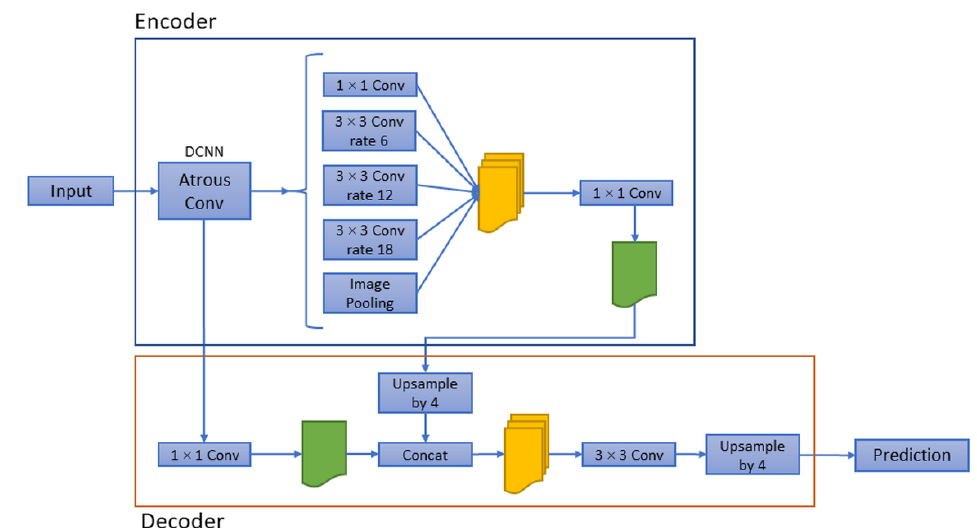
Figure 2. Network architecture of DeepLab V3+. The different rate (atrous rates) of convolutional layers in atrous convolution helps to enhance the field-of-view of the model.